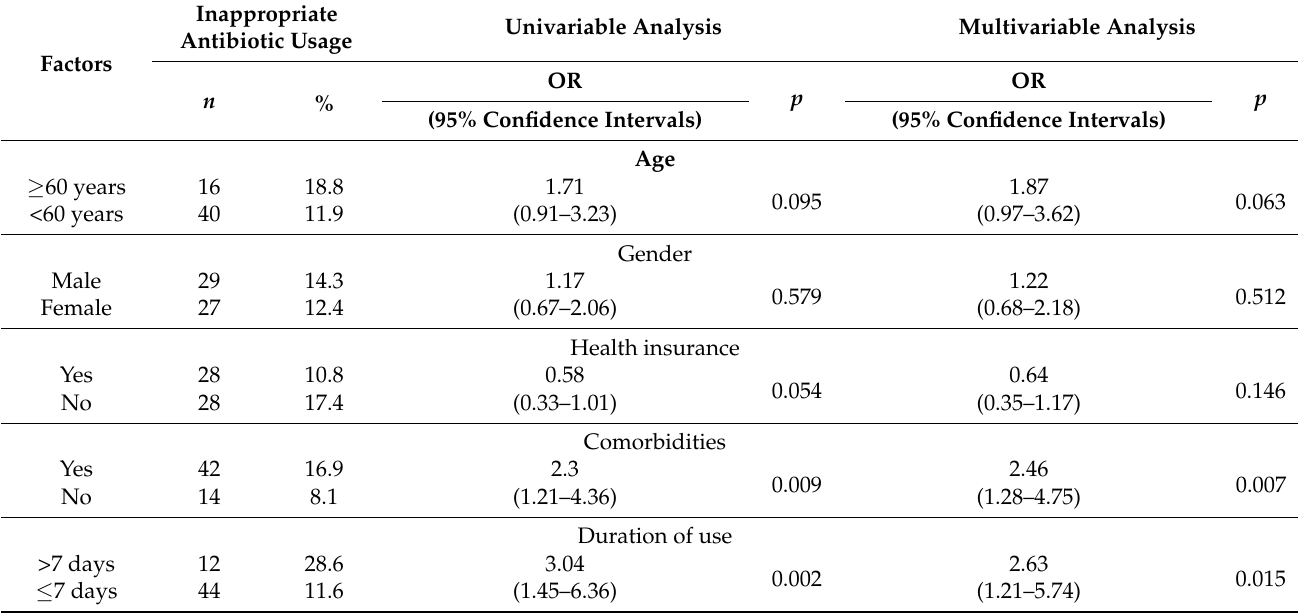
Table 3. Results of univariable and multivariable analyses and logistic regression analysis for factors associated with inappropriate antibiotic